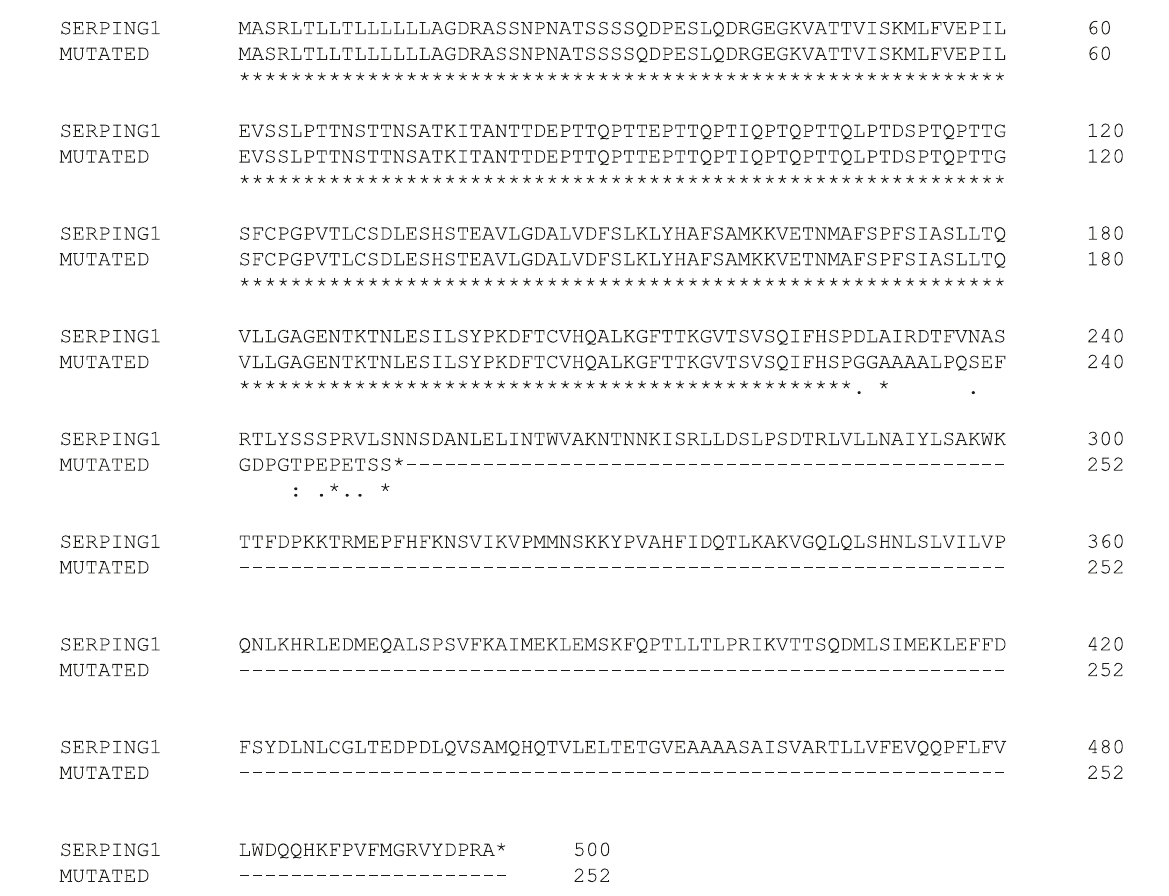
Figure 3: NG 009625.1:g.12156 14164del2009 led to the truncation of a 500-amino acid C1-INH protein into a 252-amino acid dysfunctional protein. Please note the above amino acid sequences relate only to the codons and not the mature protein with post-translational